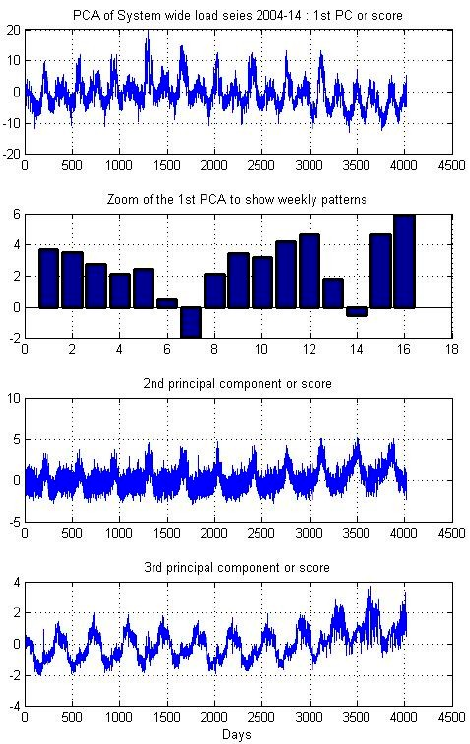
Figure 10. First four eigenvectors.